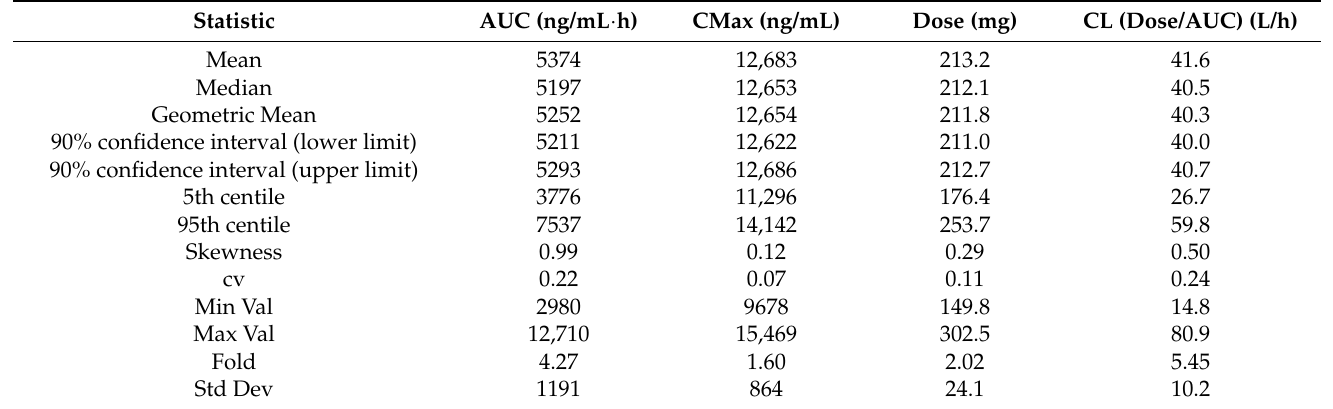
Table 3. Descriptive statistics showing the mean, variance and range of epirubicin exposure in the simulated oncology cohort.